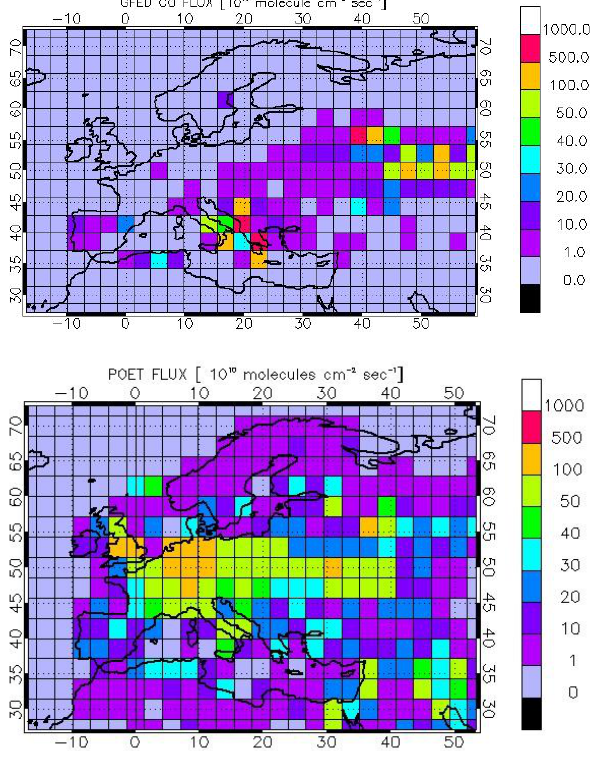
Fig. 14. Biomass burning CO emission fluxes [10 10 moleculescm − 2 s − 1 ] from GFED2 for 22/08/2007 (up- Figure 14. Biomass burning CO emission fluxes [10 10 molecules cm -2 s -1 ] from GFED2 per panel) and fixed anthropogenic emissions from POET for 22/08/2007 (upper panel) and fixed anthropogenic emissions from POET [10 10 [10 10 moleculescm − 2 s − 1 ] (lower panel), updated in 2005. molecules cm -2 s -1 ] (lower panel), updated in 2005.